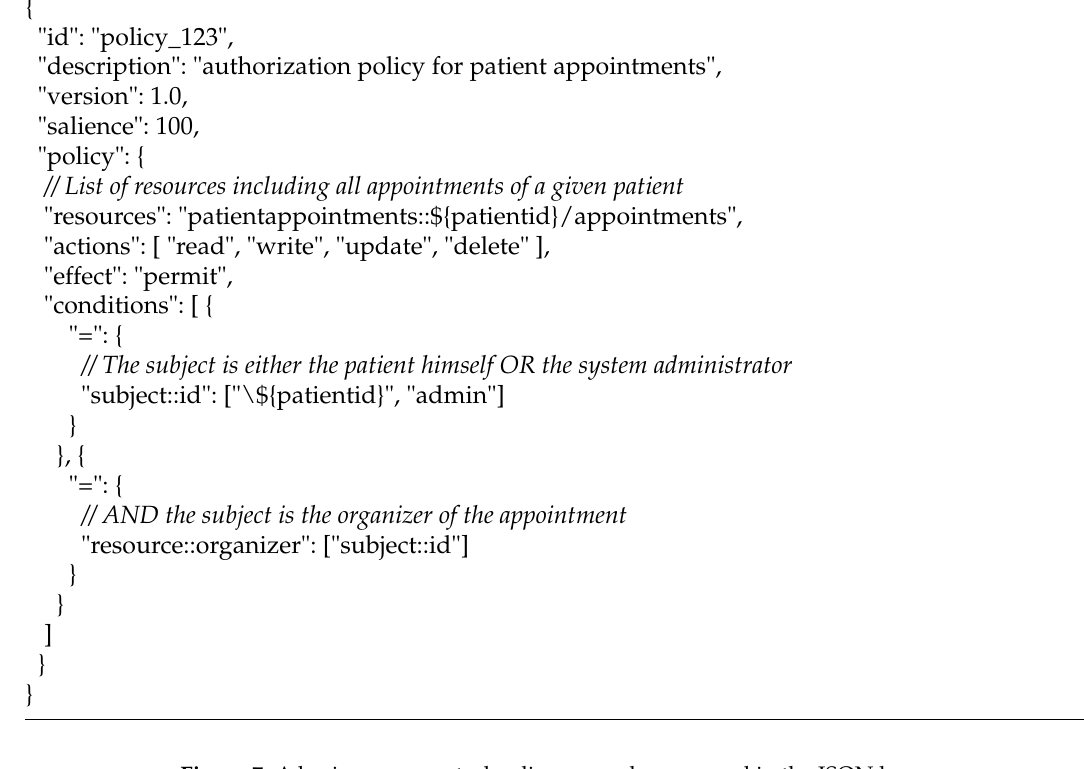
Figure 7. A basic access control policy example expressed in the JSON language.